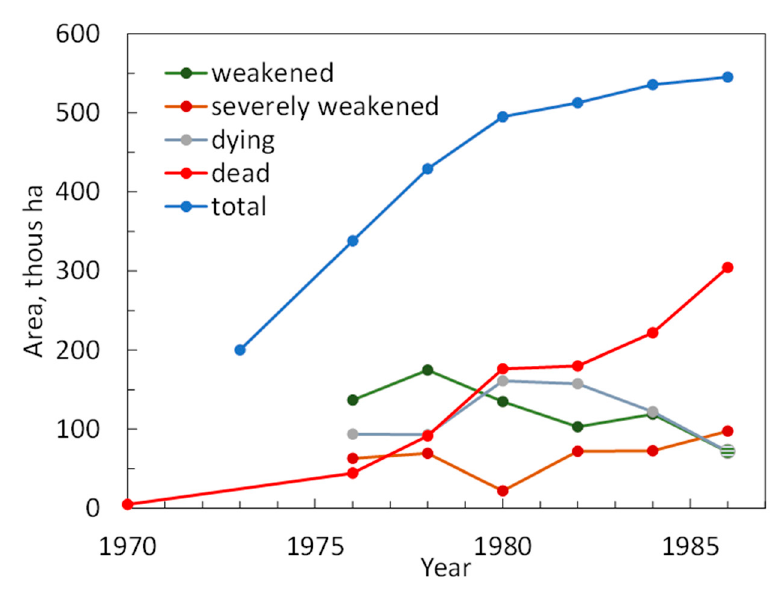
Figure A1. Dynamics of the larch forest decline and mortality. Data covered the period of the State Forest Service on-ground and airborne surveys [35]. In 1970, the area of dead forests was c. 5000 ha. The proportion of dying and dead trees in weakened, severely weakened, and dead stands were 11–25, 26–50, and 51–80%, respectively.